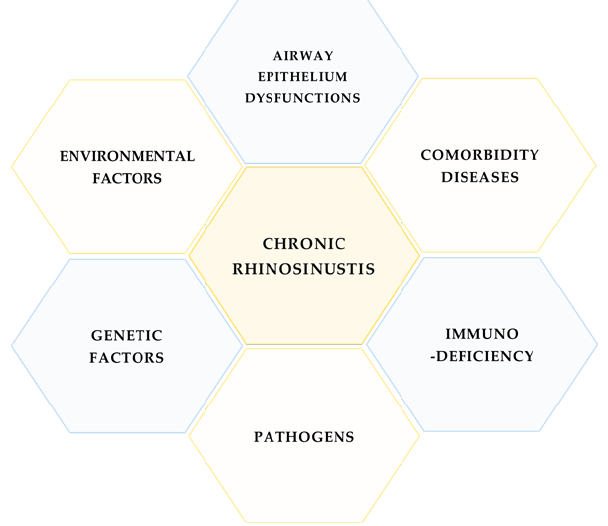
Figure 1. Main factors related to CRS.